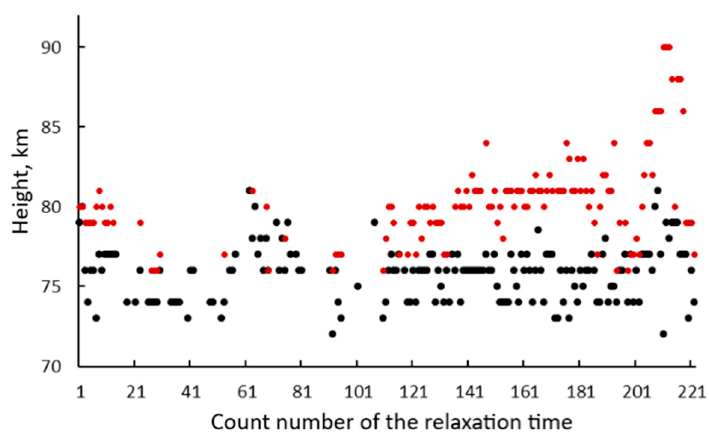
Figure 7. The temporal variation of the height in the mesosphere h 1 , at which the amplitude of the scattered signal began to decrease sharply (black dots) and the height h 2 , at which the scattered signal disappears completely (red dots) on 11 September 2019.